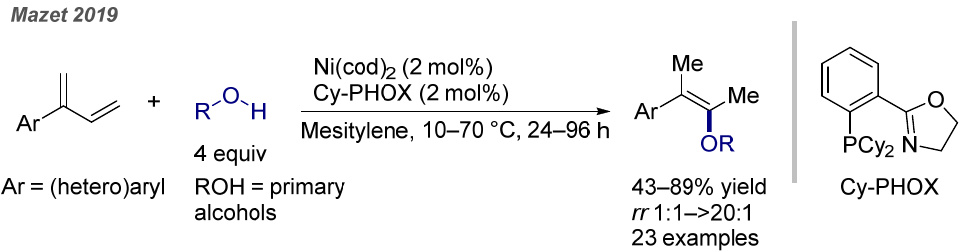
Figure 16. Nickel-catalyzed intermolecular hydroalkoxylation of butadiene and alcohols. n.d = not determined.